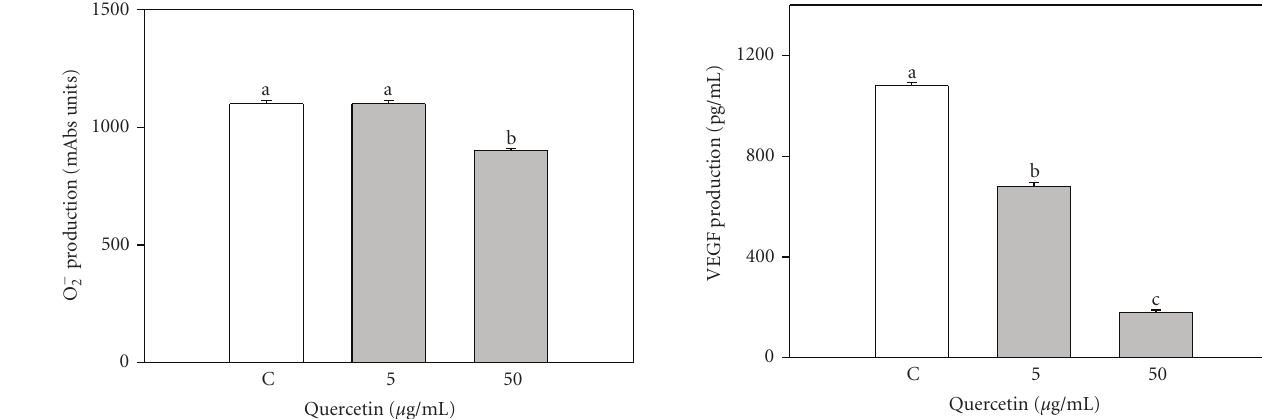
Figure 4: E ff ect of the 48-hour treatment with quercetin (5 and 50 μ g/ml) on superoxide anion (O 2 − ) production by swine granulosa cell cultured in vitro. Data represent the mean ± SEM of six replicates/treatment repeated in four di ff erent experiments. Di ff erent letters indicate significant di ff erences ( P < . 05) calculated by ANOVA and Sche ff `e’s F-test (Statgraphics package, STSC Inc., Rockville, Md, USA).